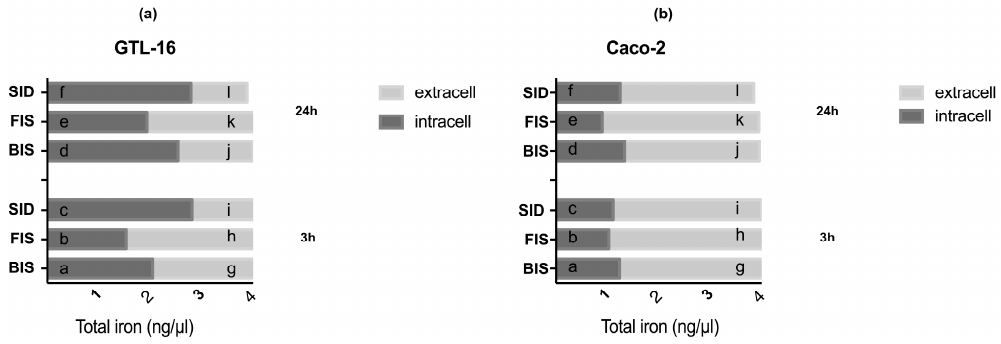
Figure 4. Total iron quantification on intracellular and extracellular environments of GTL-16 ( a ) and Caco-2 ( b ) cells treated with different iron formulations at 3 h and 24 h. The graphics report the iron movements quantified. The results are expressed as means ± SD of four independent experiments for each cell type. In ( a ) a p < 0.05 vs. b, c; b p < 0.05 vs. c; e p < 0.05 vs. d, f; g p < 0.05 vs. h, i; h p < 0.05 vs. i, k; g p < 0.05 vs. j; j p < 0.05 vs. k; k p < 0.05 vs. l. In ( b ) p < 0.05 vs. b, c; e p < 0.05 vs. d, f; b p < 0.05 vs. e; c p < 0.05 vs. f; h p < 0.05 vs. g, i; k p < 0.05 vs. j, l; g p < 0.05 vs. j; h p < 0.05 vs. k; i p < 0.05 vs. l. Table 1. Apical to basolateral permeability. Apparent permeability values (Papp) represent mean data ± standard deviation (SD) from three separate measurements of each compound tested in one experiment, each with four independently analyzed.